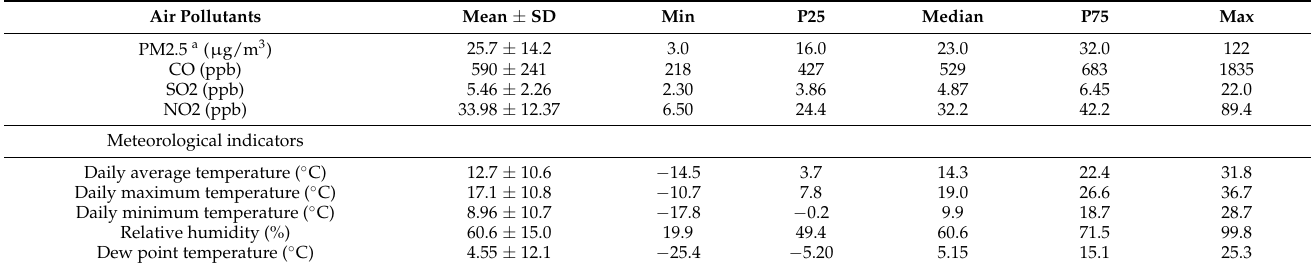
Table 1. Average air-pollutant concentration and weather conditions during the study period (2005 to 2014). Air